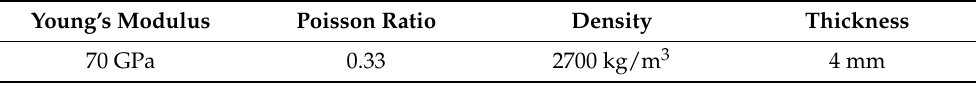
Table 1. Material properties of an aluminum plate specimen.